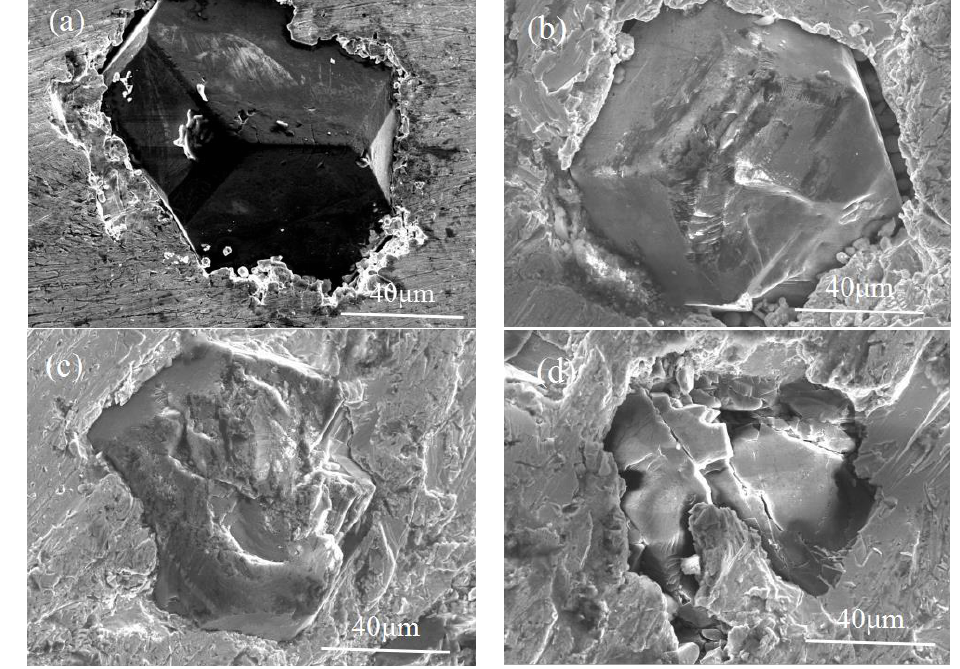
Figure 11. Wear characteristics of diamonds brazed by milled Cu-based alloy containing 0.75% Ce ( a ) Integrity; ( b ) micro-fracture; ( c ) fracture; ( d ) rubdown.